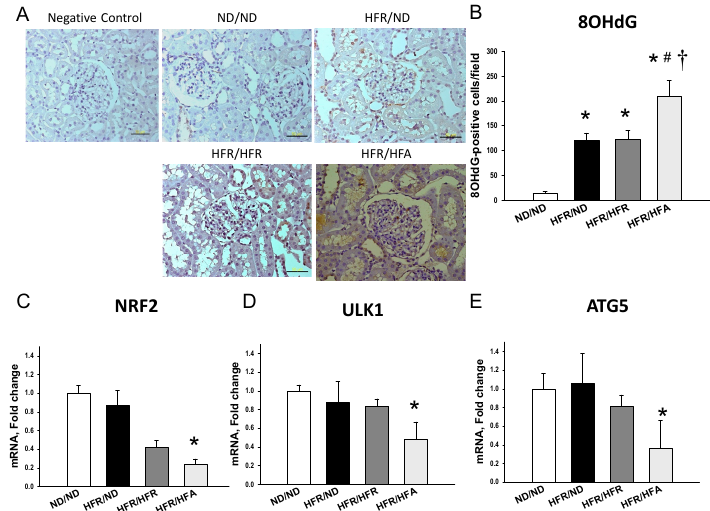
Figure 4. ( A ) Light micrographs illustrating immunostaining for 8-hydroxydeoxyguanosine (8-OHdG) in the kidney in male offspring at 12 weeks of age. Bar = 50 μ m; ( B ) quantitative analysis of 8-OHdG-positive cells per microscopic field (400×); Effect of maternal and post-weaning high-fructose (HFR) and post-weaning high-fat (HFA) intake on mRNA expression of ( C ) Nfr2 , ( D ) Ulk1 , and ( E ) Atg5 in male offspring kidneys at 12 weeks of age. n = 8/group. * p < 0.05 vs. ND/ND; # p < 0.05 vs. HFR/ND; † p < 0.05 vs. HFR/HFR.